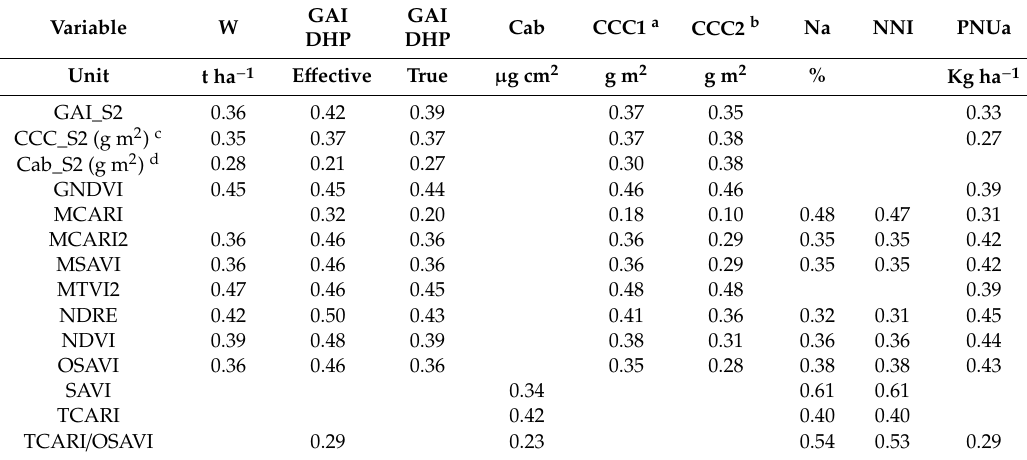
Table 8. Coe ffi cients of determination for the relationship between field measured or calculated BVs and satellite (S2) derived Vis and S2_BVs for wheat crop 2019. Only statistically significant values are